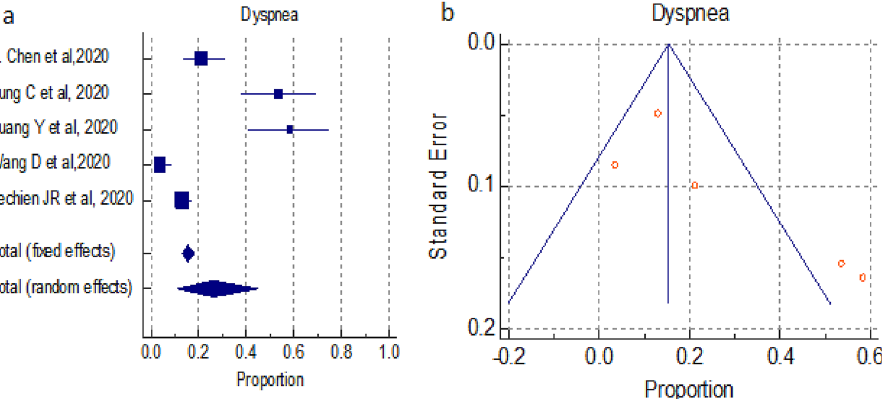
Figure 8. ( a ) Forest plot showed pooled prevalence of Dyspnea among patients with COVID-19. ( b ) Funnel plot showed publication bias among studies evaluating neurological complications of COVID-19.